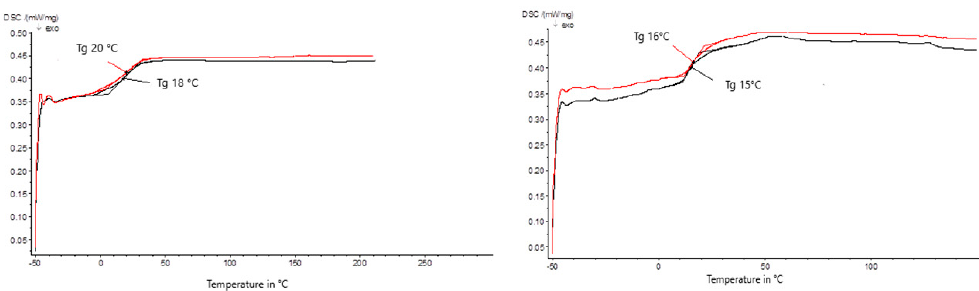
Figure 6. Differential scanning calorimetry (DSC) results for recycled polyvinyl butyral before ( left side ) and after ( right side ) exposure to laboratory light sources. Legend to the Figure 6: Black line- 1st heating of recycled polyvinyl butyral before and after exposure to laboratory light sources; Red line-2nd heating of recycled polyvinyl butyral before and after exposure to laboratory light sources